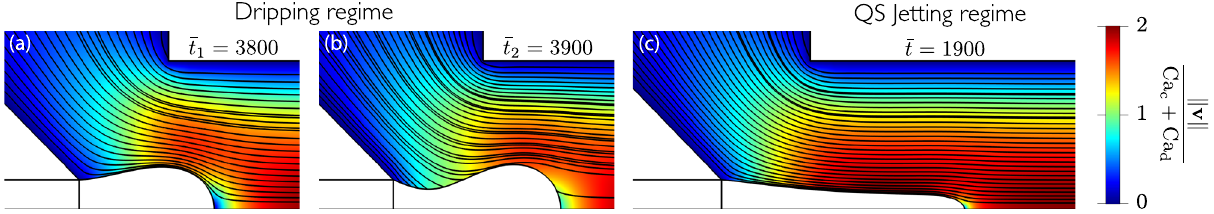
Figure 9. Axisymmetric simulations in transient using couple 1 (see Table 1) and Ca d = 8 · 10 − 5 (QS limit). The flow field is represented by streamlines and rescaled velocity norm || v c || /( Ca c + Ca d ) as color code. The timescale is R n µ c /γ = 7 µ s. ( a , b ) Dripping regime with Ca c = 0.1 for a time before ( a ) and after ( b ) the folding